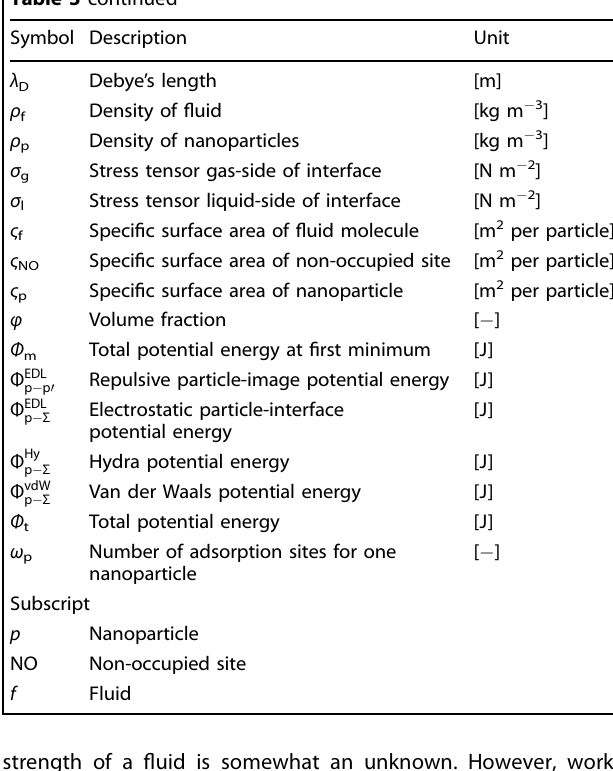
strength of a fl uid is somewhat an unknown. However, works have indicated that for deionized water, typical ionic strength values are measured of the order of I = 1 mol/m 346 . This value is assumed for all the fl uids used. The values for λ 0 and ζ p depend strongly on the experimental conditions and only ranges can be indicated. Decay lengths, λ 0 , of values up to 2.2 nm are reported for several systems 20,37,41 . The zeta-potentials ζ p of nanodisper- sions were typically found to be approximately between − 75 and − 25 mV 20,34,43 . Educated guesses, not affecting the analysis in this work, for these two parameters within these indicated ranges are implemented in Table 4 for the calculation of the equilibrium constant. The obtained equilibrium constants for the nanoparticle dispersions are shown later in Table 5.